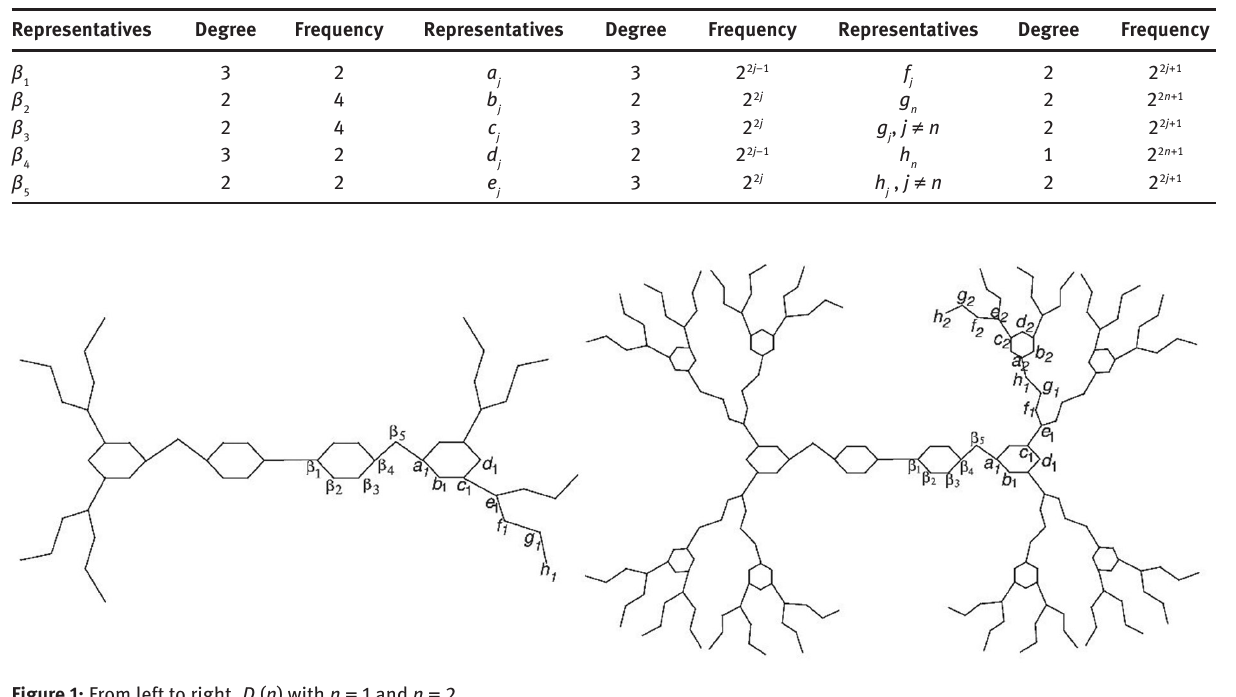
Figure 1: From left to right, D